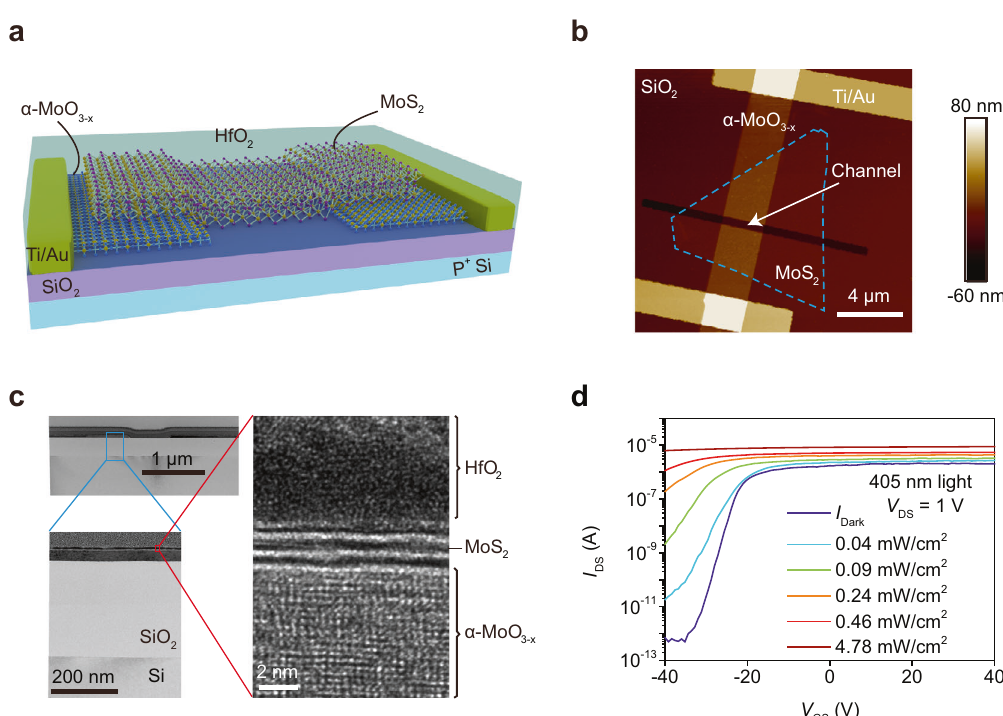
Fig. 1 The molybdenum-based phototransistor. a Schematic of the α -MoO 3-x /MoS 2 / α -MoO 3-x phototransistor. Using HfO 2 as capping layer, MoS 2 as channel material, α -MoO 3-x as contact electrodes, Ti/Au as metal contact, SiO 2 as dielectric layer and P + Si as gate electrode. b Atomic force microscope (AFM) image of the device. The dash line is ouline of MoS 2 channel. c Cross-sectional transmission electron microscope (TEM) image of the phototransistor showing the high-quality interface between α -MoO 3-x and MoS 2 . d Transfer characteristics ( I DS − V GS ) of the device at V DS = 1 V using incident light with a wavelength of 405 nm and increasing power density P in at room temperature. P in = P π − 1 r − 2 , where P is the actual laser output and r is the radius of the laser spot (about 500 μ